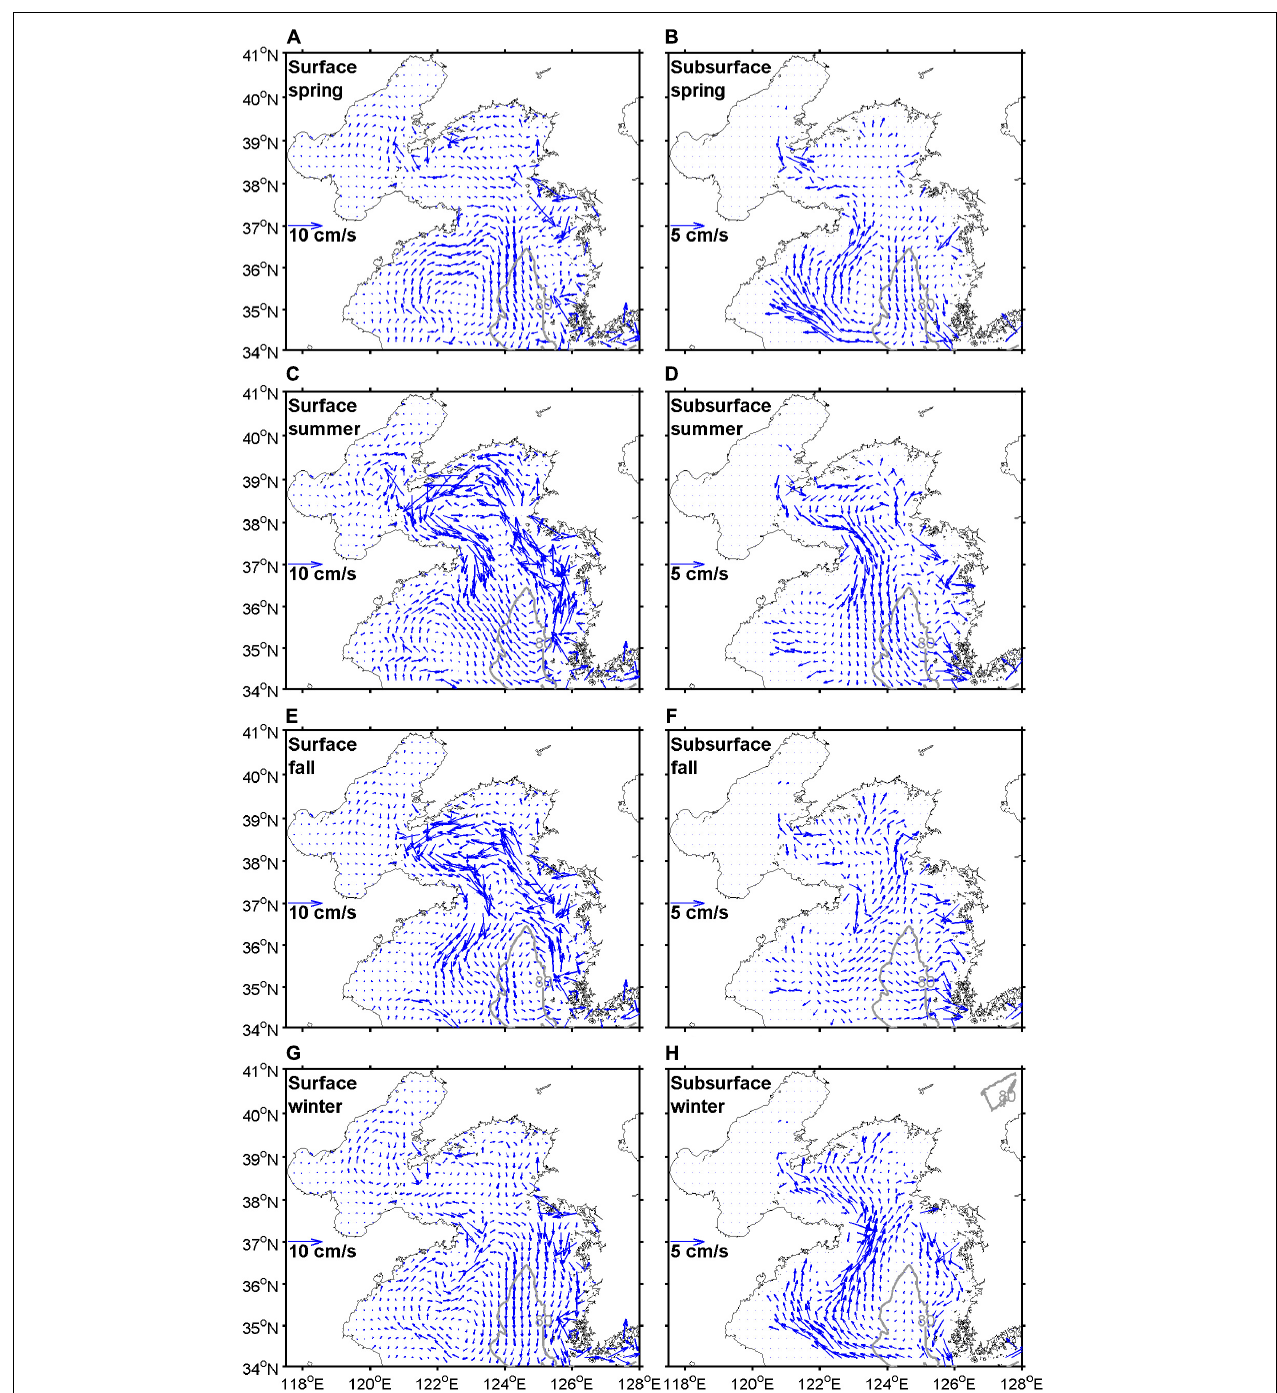
FIGURE 11 | Horizontal velocity distributions at the surface (A–D) and subsurface (E–H) layers during spring (A,E) , summer (B,F) , fall (C,G) , and winter (D,H) averaged for the period 2006–2019. The surface and subsurface layers are averaged from the surface to 30 m depth and from 30 m depth to the bottom,